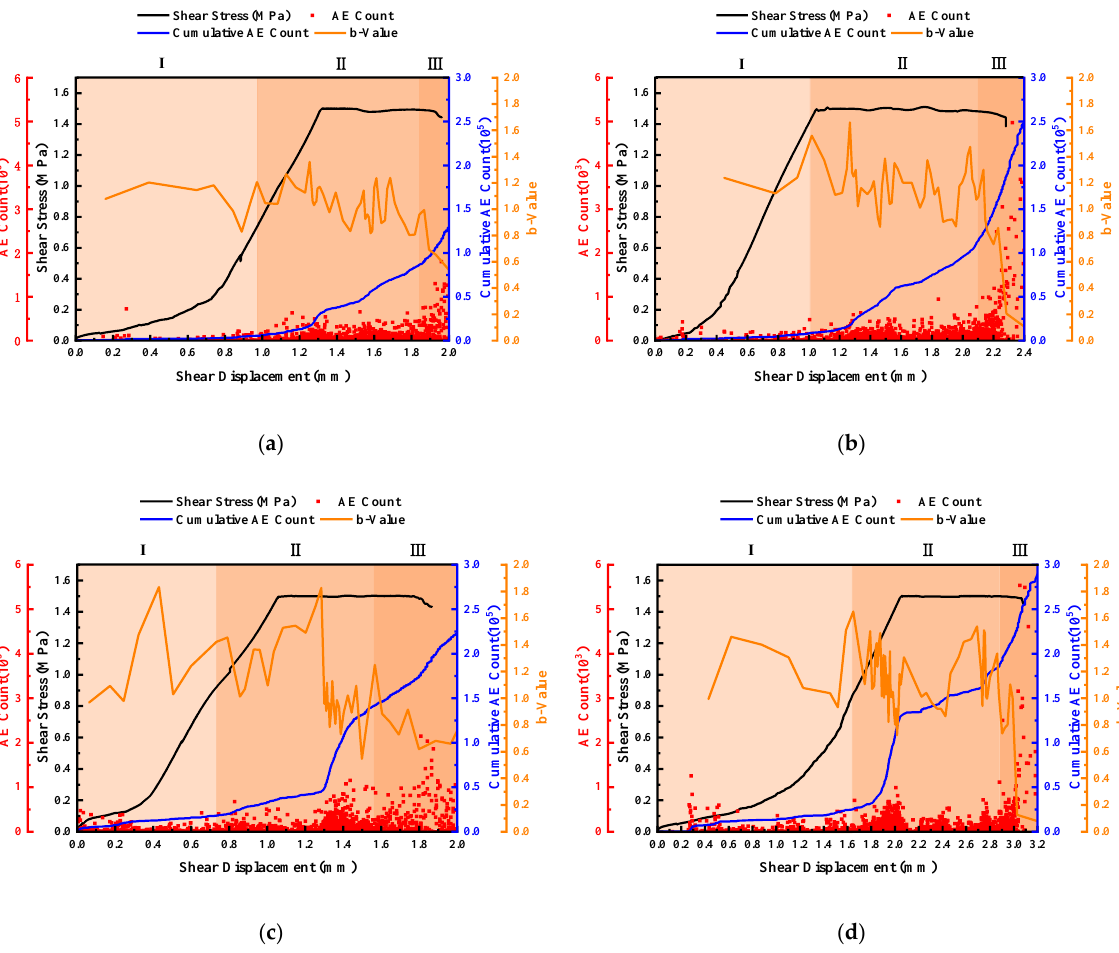
Figure 15. Acoustic emission rules of joints with different roughness. ( a ) JRC = 0 – 2. ( b ) JRC = 6 – 8. ( c ) JRC = 12 – 14. ( d ) JRC = 18 – 20.